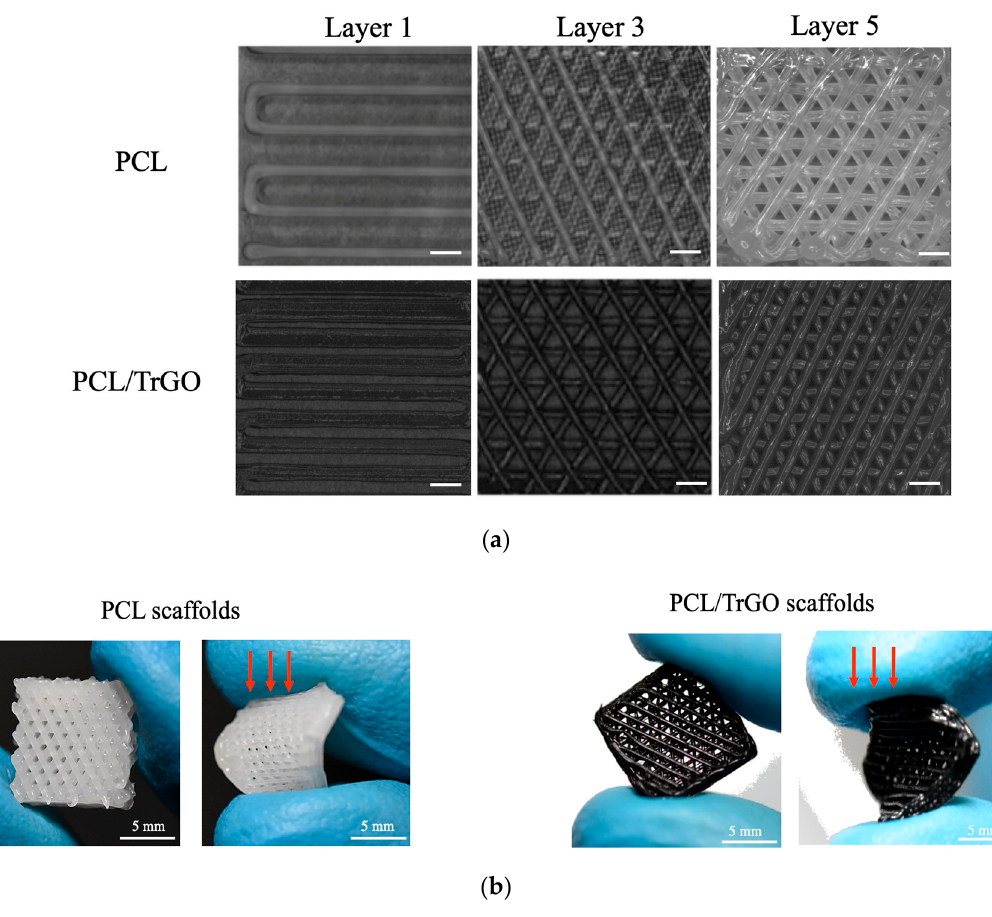
Figure 4. ( a ) Images captured from the scaffold printing process of layers 1, 3, and 5, scale bar 300 µm; ( b ) optical photographic of the scaffolds frontal view (left) and applying qualitative stress (right).